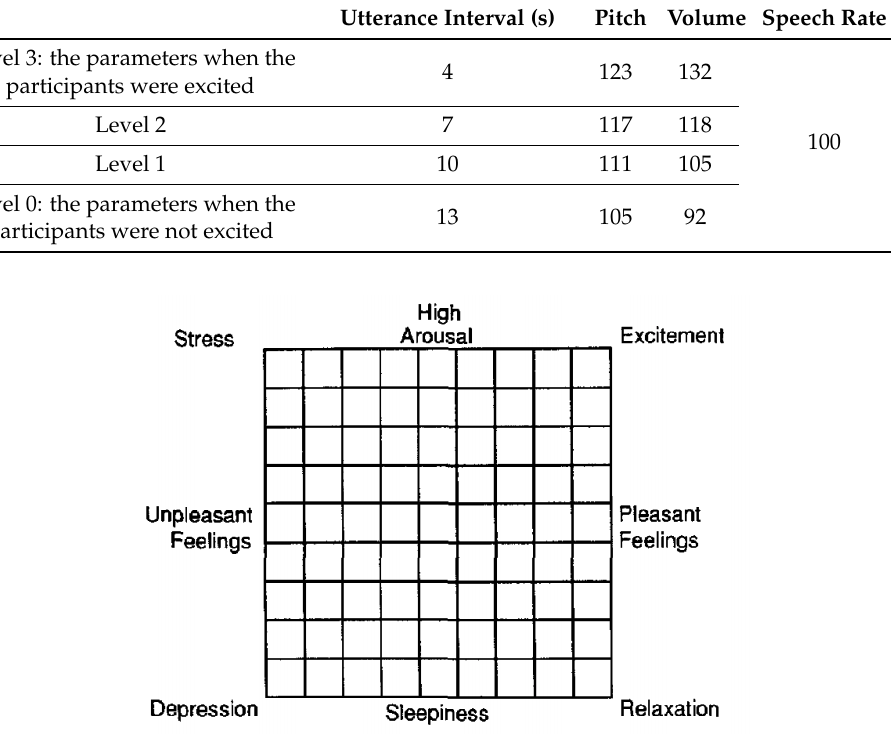
Figure 6. Affect grid for quantifying